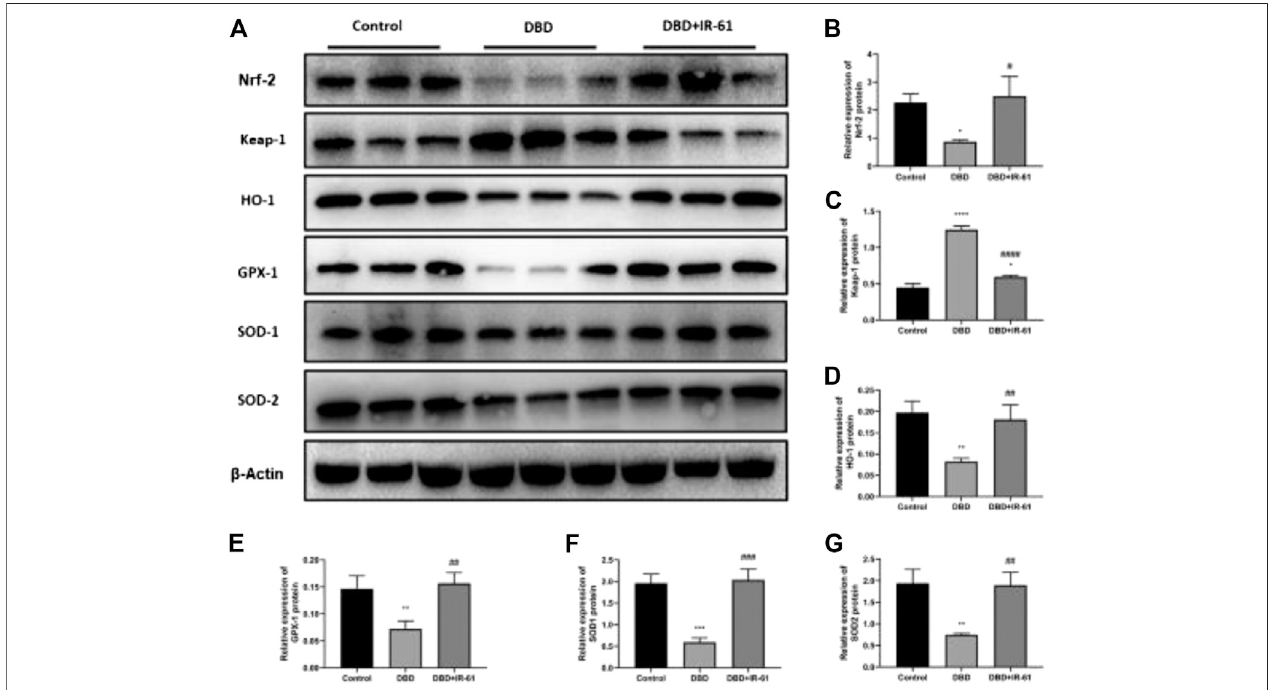
FIGURE6| IR-61activatedNrf2andincreasedantioxidant-relatedproteinlevels. (A – G) WesternblotanalysisofNrf2,Keap1,HO-1,GPX-1,SOD-1,andSOD-2in bladder tissue and quantitative analysis. Data indicate the mean ± SD (* p < 0.05, ** p < 0.01, *** p < 0.001, **** p < 0.0001 vs. control group, # p < 0.05, p < 0.01, ### p < 0.001, #### p < 0.0001 vs. DBD group).